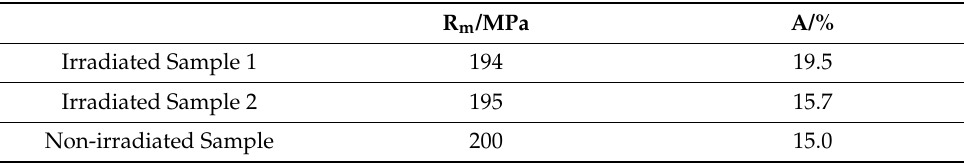
Table 8. Summary of tensile